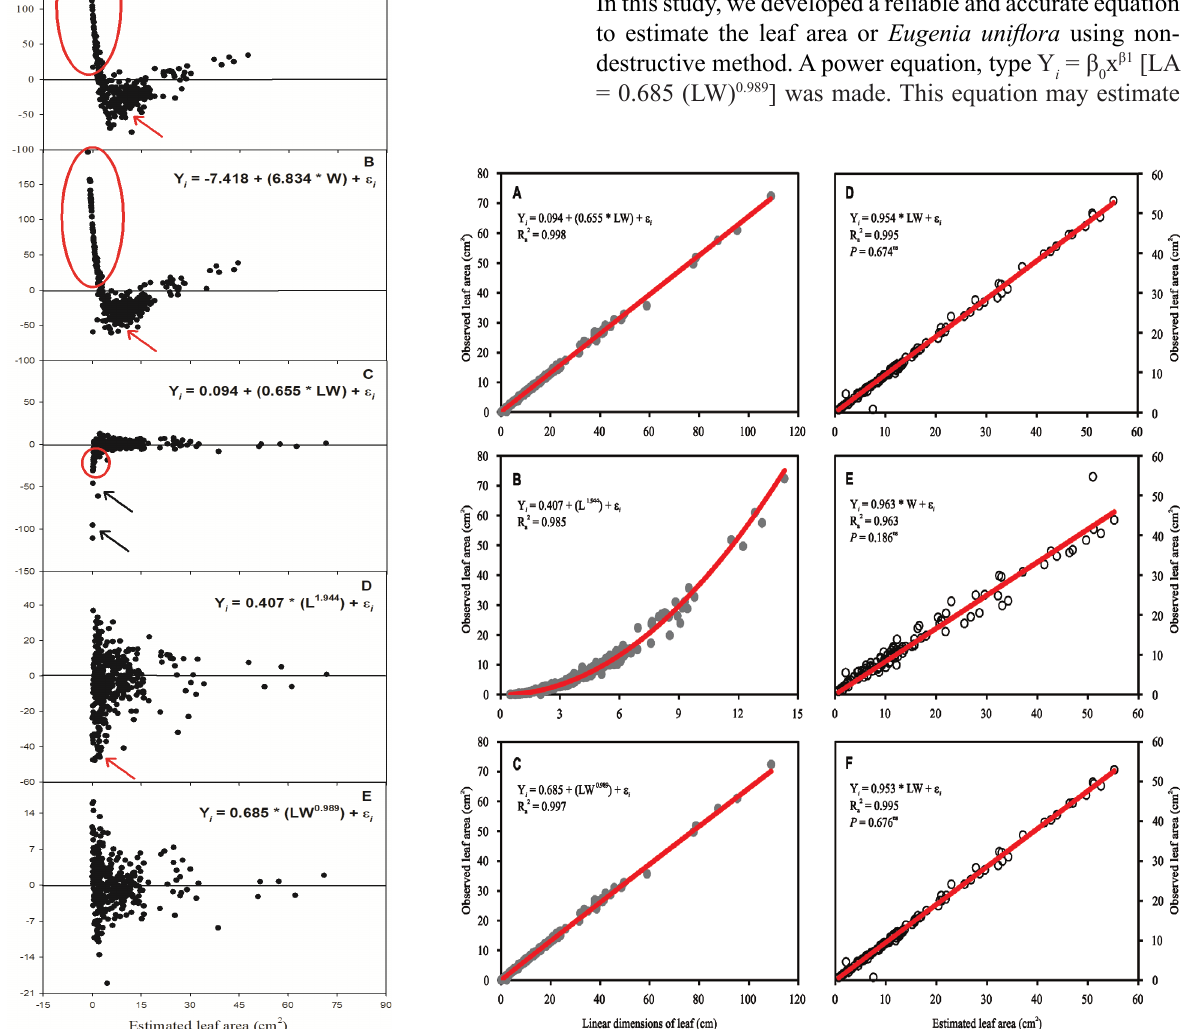
Figure 2. The relationship between estimated Figure 3. The relationship between observed leaf area and linear leaf area and dispersal pattern of residuals to dimensions of leaf (A, B and C) or between estimated leaf area (D, E each selected equations. Red oval shape denote and F) for model #3 (A and D), model #7 (B and E) and model #9 (C strong underestimated (A, B) or overestimated and F). L, leaf length; LW, product of leaf length and leaf width; ns, not (C) leaf area. Red arrows denote strong biased significant; R a2 , coefficients of determination adjusted for the degrees of estimated leaf areas, mainly in the smaller leaves, while black arrows denote slightly skewed estimated leaf areas. See further details in the text.